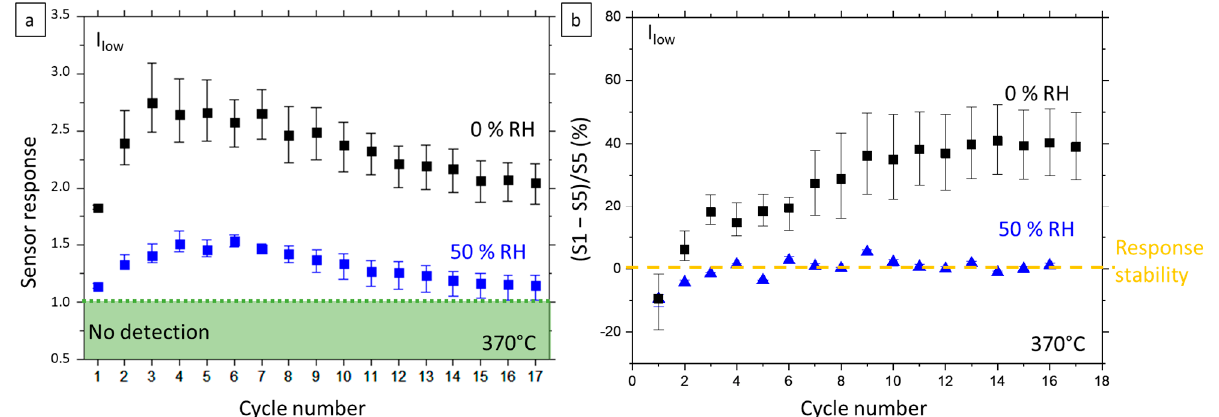
Figure A3. Evolution of DLow devices response in “Humidity Study” ( a ) for the first exposure to 2 ppm of acetone under dry and 50% RH humid atmosphere for the whole study, ( b ) Relative loss of sensor response between the first (S1) and the fifth (S5) successive injection of acetone for all 17 gas exposure cycles in “Humidity Study”. Black squares refer to results in dry atmosphere and blue triangle in humid atmosphere. The symbol represents the mean response calculated from 3 devices and the upper and lower lines represent respectfully the value of higher and lower responses obtained. Dashed line in panel b refers to stability of the response towards successive injections of acetone.